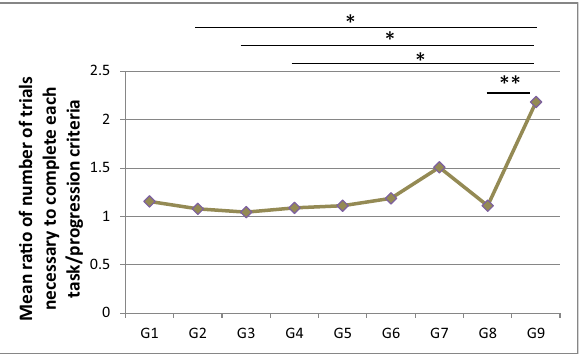
Figure 9: Progression rates in each game.